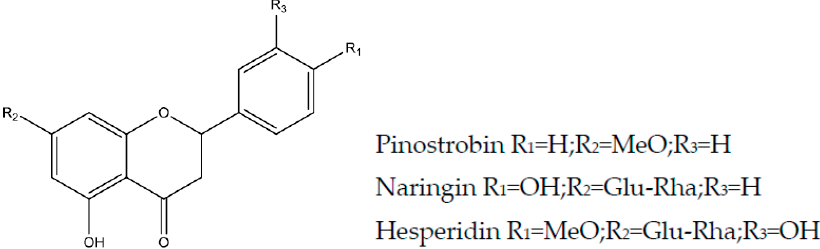
Figure 5. Flavanones with gastroprotective and/or anti-ulcer activity.